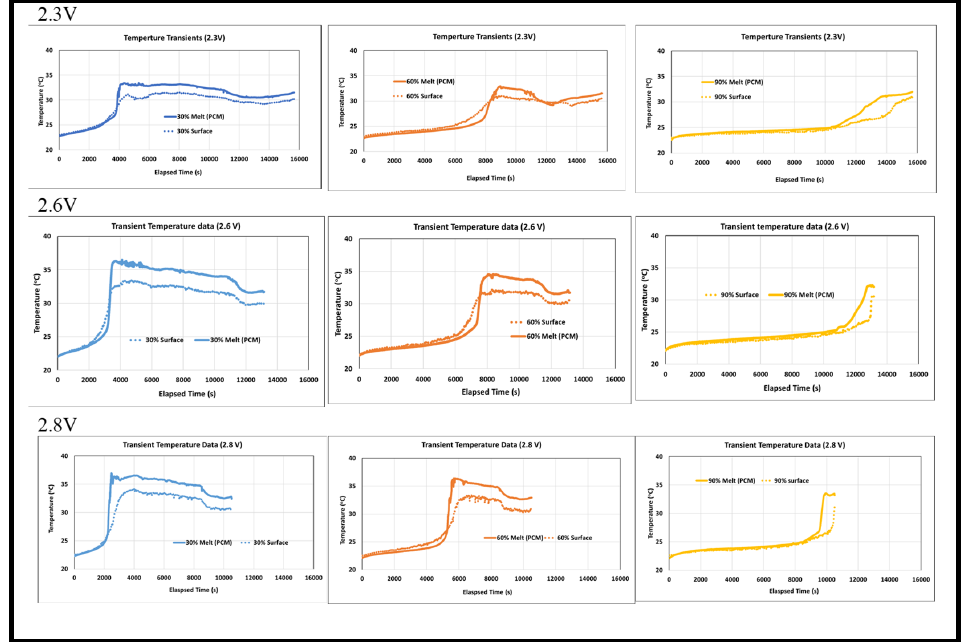
Figure A2. Comparison of the transient PCM-temperature data and transient surface-temperature data for different heater input voltage (and power input) conditions recorded in the experiments.